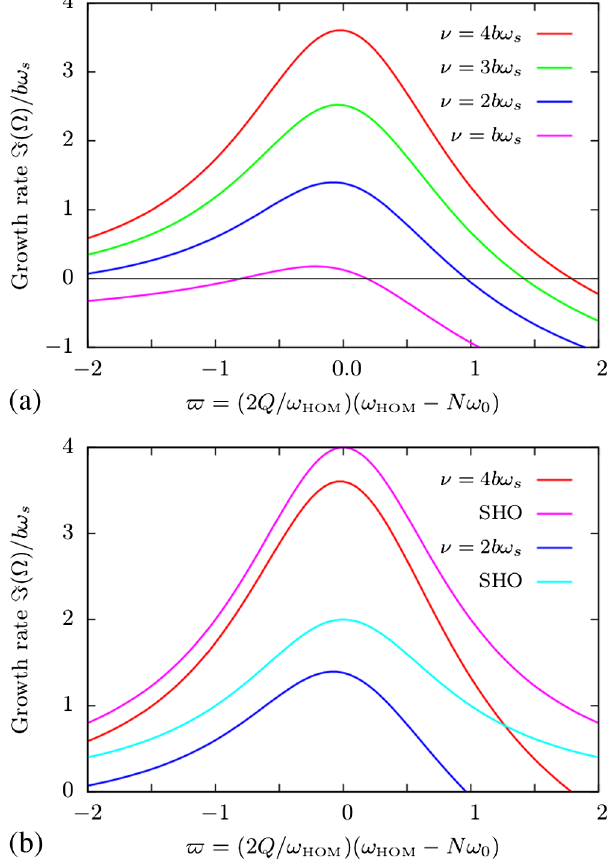
FIG. 1. Theoretical coupled-bunch growth rate as a function of the HOM frequency difference from a revolution harmonic. (a) plots the theoretical growth rate as we increase the matrix growth rate λ from being equal to the nonlinearity to four times that. (b) shows the effect of Landau damping by comparing two cases from panel (a) to those os a simple harmonic